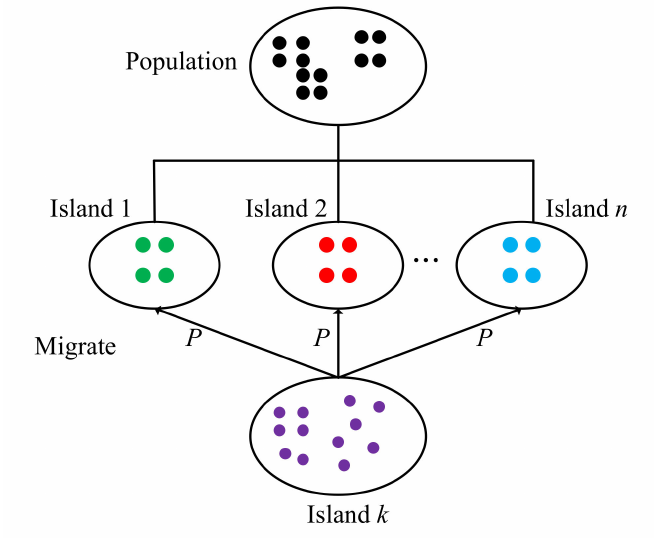
Figure 1. The soft-island model.